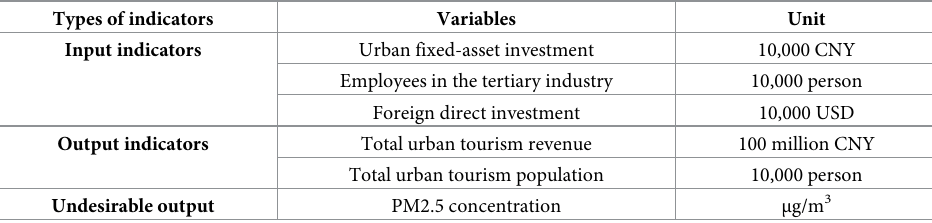
Table 1. Measure indicator system for the efficiency of